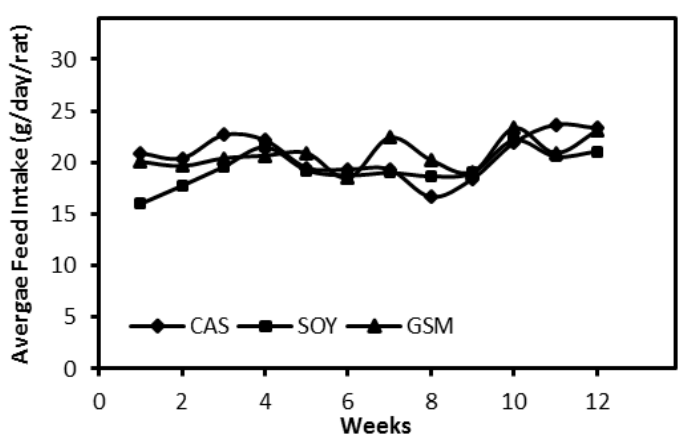
Figure 1. Weekly average feed intakes of three groups over the 12-week feeding period. Average